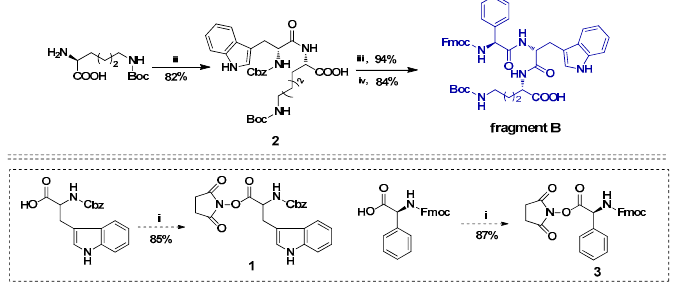
Figure 2. HPLC spectra of fragment B.